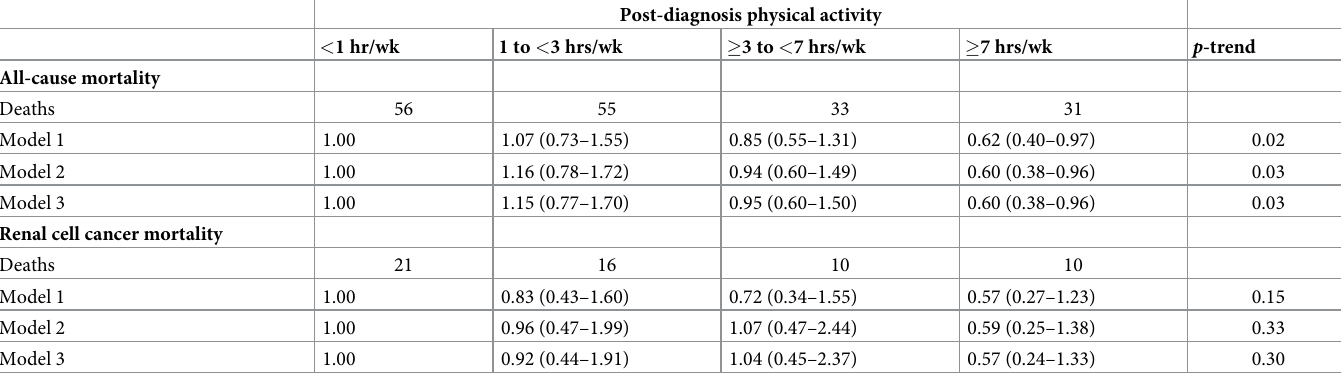
Table 2. Hazard ratios and 95% confidence intervals of mortality among individuals diagnosed with renal cell cancer according to post-diagnosis moderate to vigor- ous physical